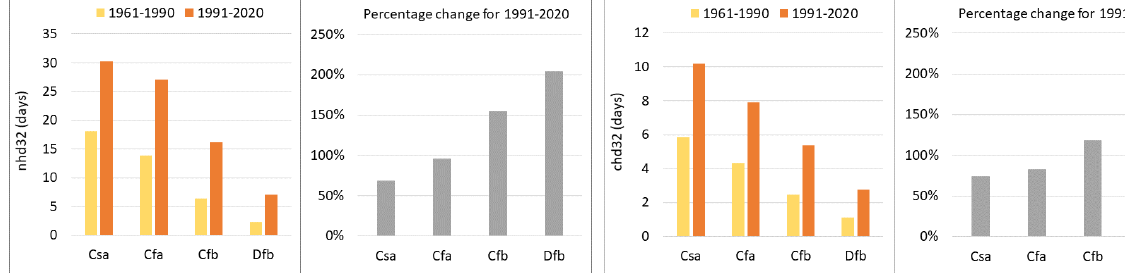
Figure 4. Multiyear means of nhd32 ( left panel) and chd32 ( right panel) indicators for periods 1961–1990 and 1991–2020 and percentage changes relative to 1961–1990 by zones of the Köppen– Geiger climate